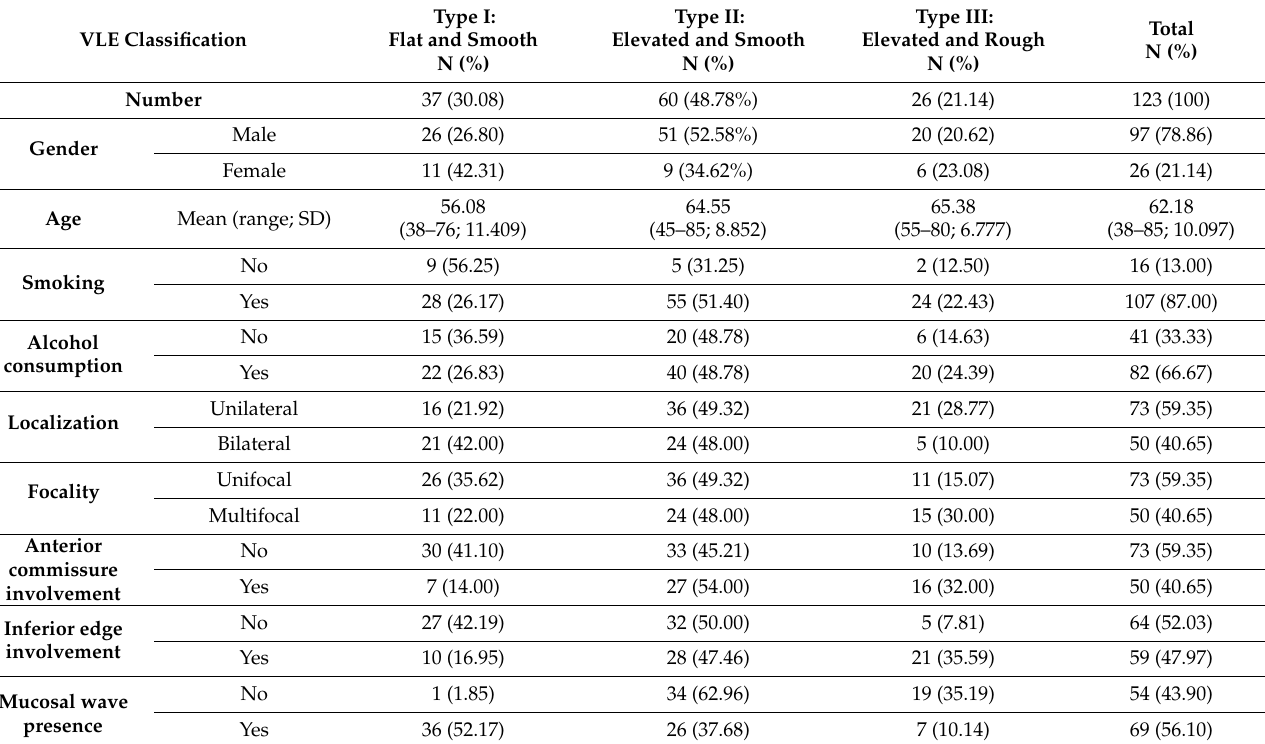
Table 1. Clinical characteristics of vocal fold leukoplakia in the enrolled